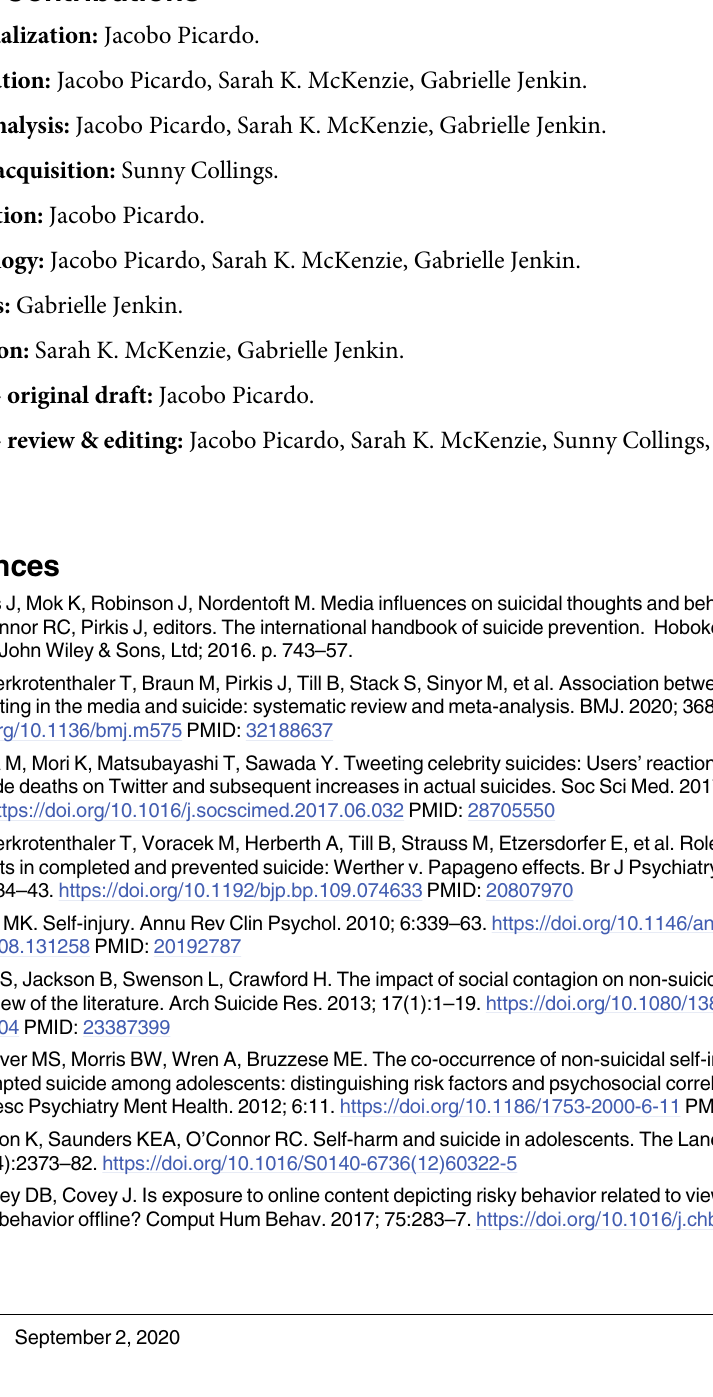
S1 Table. Detailed quality appraisal of included